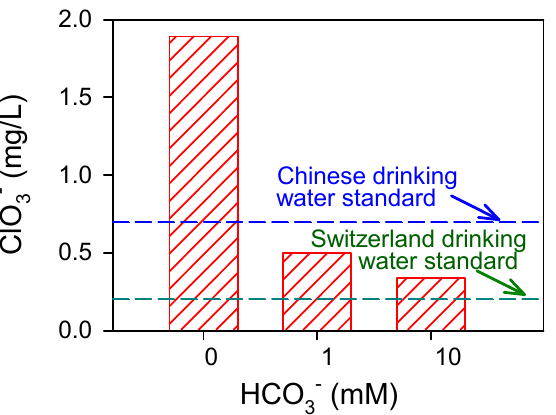
− on ClO − generation in the WMF/Fe 0 /H Figure 6. Influence of HCO 3 − on ClO 3 − generation in the WMF/Fe 0 /H 2 O 2 system in the presence of Figure 6. Influence of HCO 3 3 of Cl – . Experimental conditions: [BPA] 0 = 0.2 mM, [Cl – ] = 2 mM, [Fe 0 ] 0 = 7 mM, [H 2 O 2 ] 0 = 6